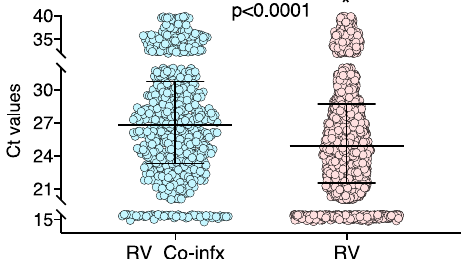
Figure 3. Comparison of RV viral loads in children compatible symptoms and RV mono-infections versus RV viral co-infections. RV_Co-infx: RV co-infections with another respiratory virus.